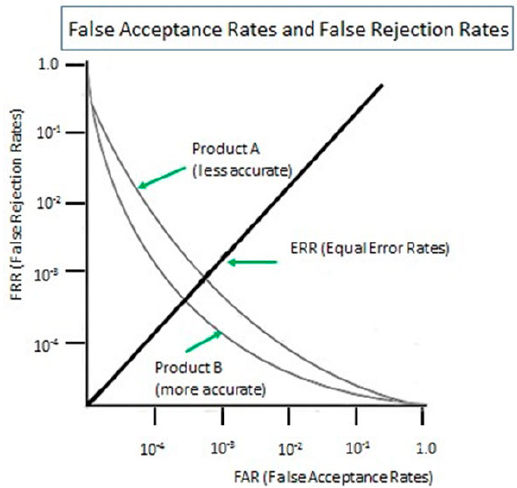
Figure 7. FAR–FRR interaction graph.